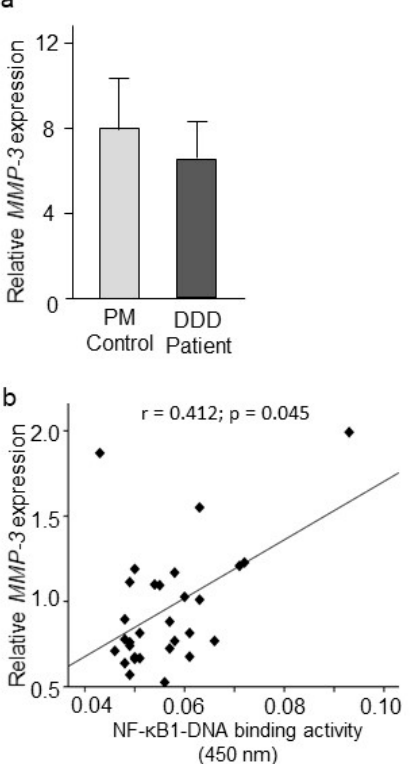
Figure 2. MMP ‐ 3 gene expression and association to NF ‐κ B. ( a ) Relative expression of MMP ‐ 3 in